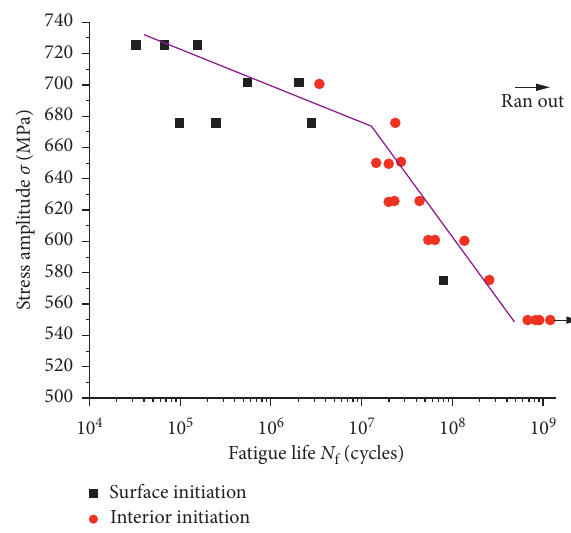
Figure 4: Experimental result of fatigue property for material